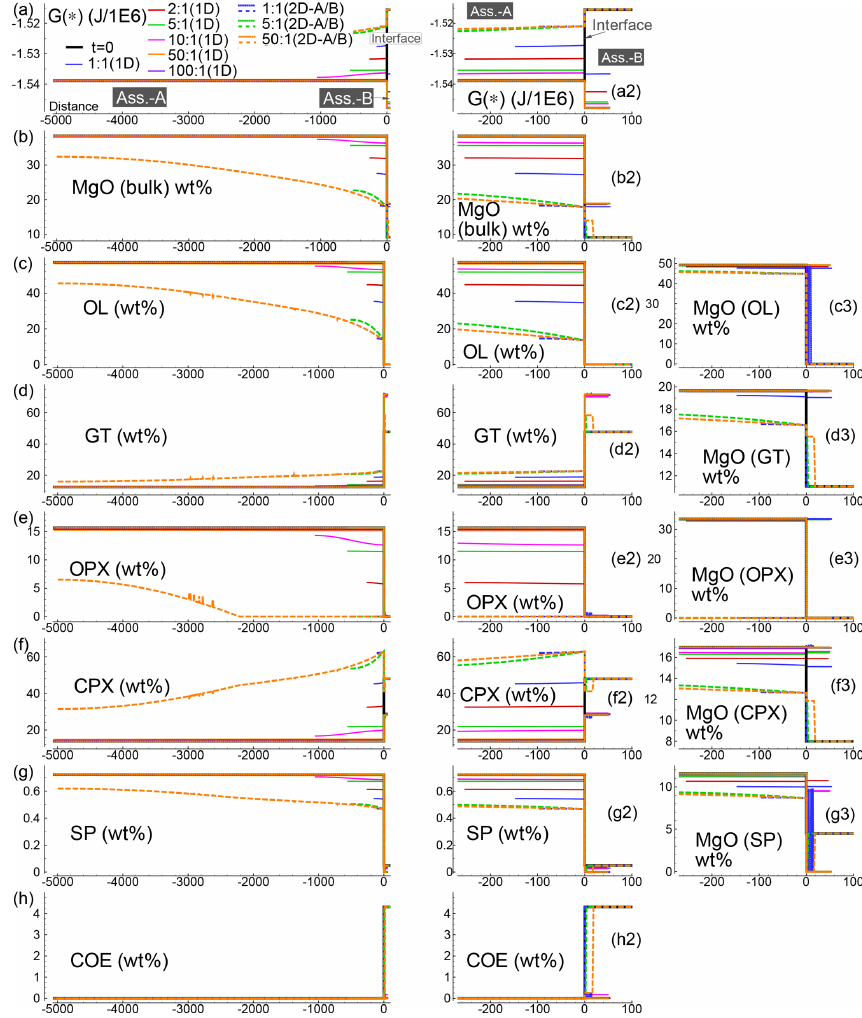
Figure 7. Summary of the results for all the 1-D and 2-D numerical models at conditions close to chemical equilibrium for the whole system. The models consider different initial proportions of the two assemblages. In addition, for the 2-D models it is assumed that either assemblage A or B enters from the top side at time 100000 (arbitrary units) with velocity 0.00625 (arbitrary units). For the 2-D models the profiles represent a horizontal section at the vertical middle point ( D y / 2). (a) Spatial variation of G( ∗ ) . For clarity, the plot of the 2-D model with 50 : 1 ( B ) is truncated at x ∼ 500. (a2) Enlarged view of G( ∗ ) near the interface. (b) Variation of bulk MgO (wt%). (b2) Enlarged view of bulk MgO near the interface. (c–g) Spatial variation of mineral abundance. (c2–g2) Mineral abundance zoomed near the interface. (c3–g3) MgO content in the associated minerals near the interface. (h, h2) Distribution of coesite (SiO 2